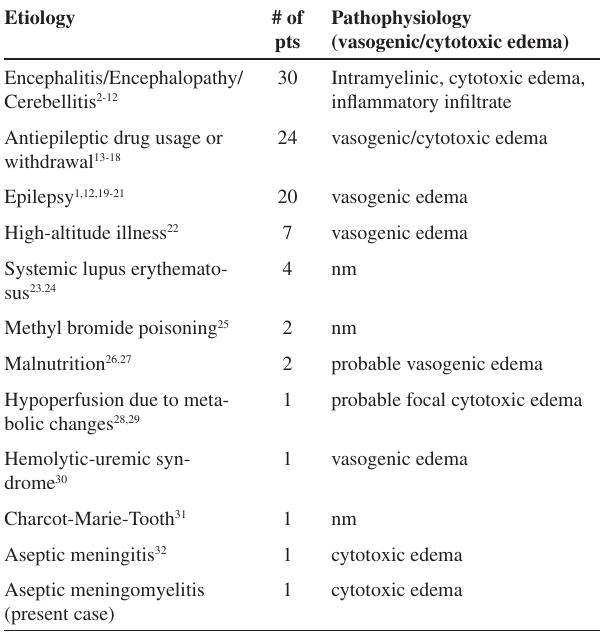
Table 1 - Etiologies of isolated reversible lesions in the splenium of the corpus